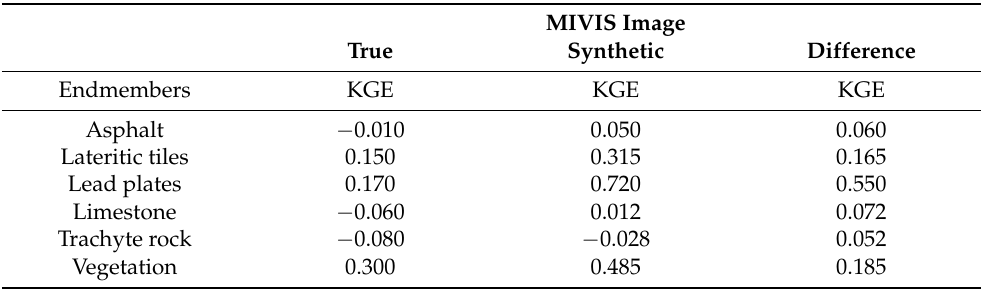
Table 7. In the fifth method, spatial accuracy is measured with KGE values that were obtained from true and synthetic images and the absolute difference between these